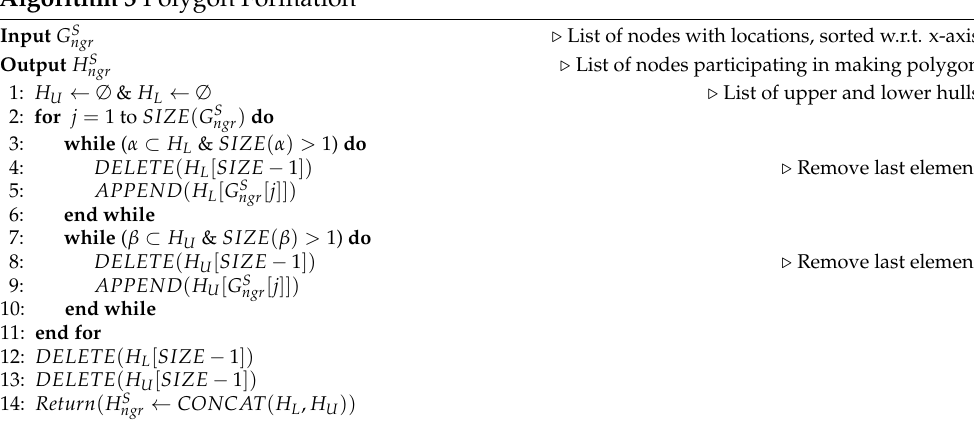
Algorithm 3 Polygon